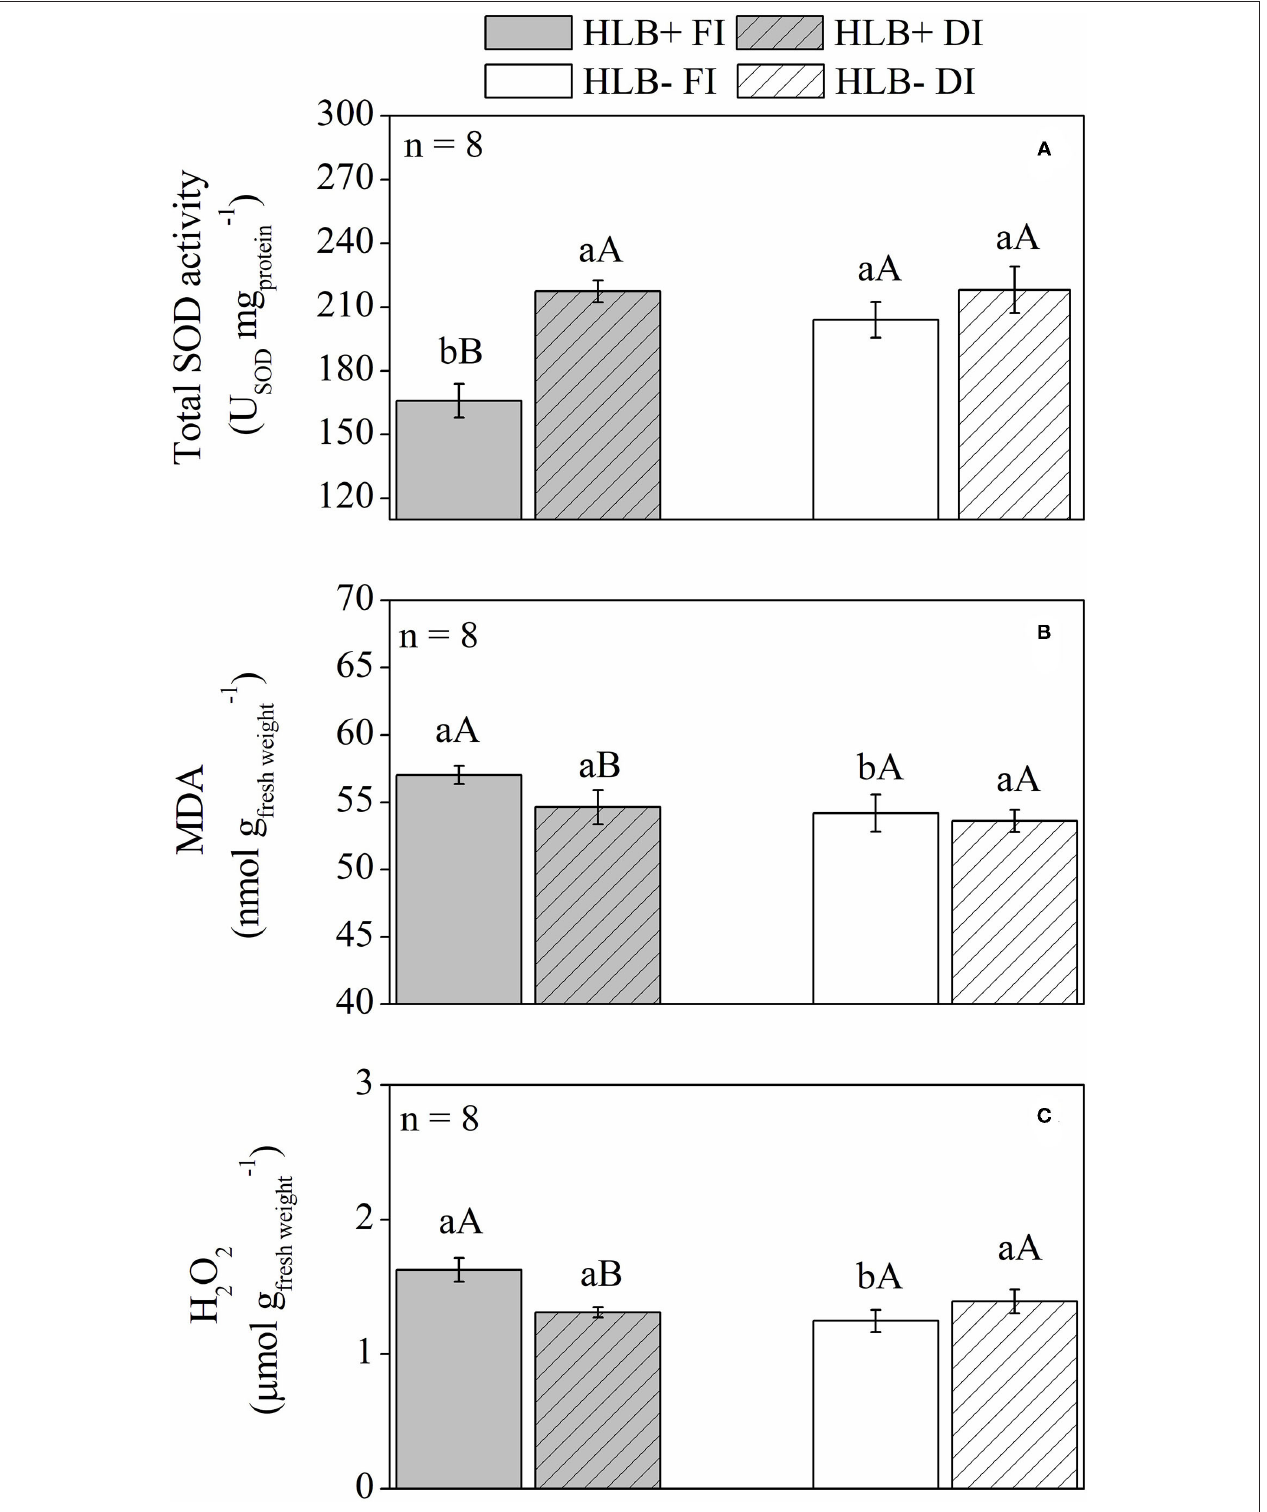
FIGURE 6 | Superoxide dismutase activity [ SOD , (A) ], lipid peroxidation [ MDA , (B) ], and hydrogen peroxide content [H 2 O 2 , (C) ] of leaves of “Valência” orange trees [ Citrus sinensis (L.) Osbeck] grafted on citrumelo “Swingle” rootstock [ Citrus paradisi Macfad. x Poncirus trifoliata (L.) Raf.] either infected with “ Ca . Liberibacter asiaticus” ( + ) or healthy (–) and exposed to two water management treatments: fully irrigated (FI) and deficit-irrigated (DI). Values are mean ± SE ( n = 8). Means followed by the same letter do not differ between water management treatments within the same HLB infection conditions (upper case) or between HLB infection conditions within the same water management treatment (lower case) according to unpaired Student’s t -test at 5% probability.